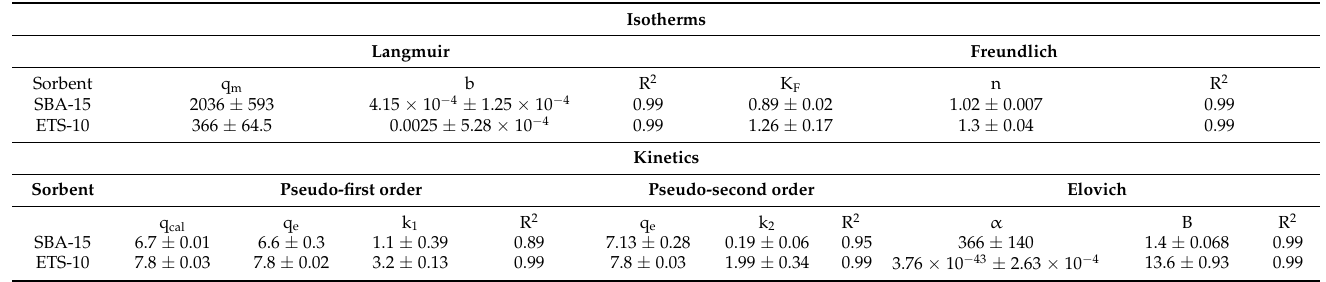
Table 1. Equilibrium isotherms and kinetic parameters for the sorption of indium on silica SBA-15 and titanosilicate ETS-10 sorbents. Isotherms Langmuir